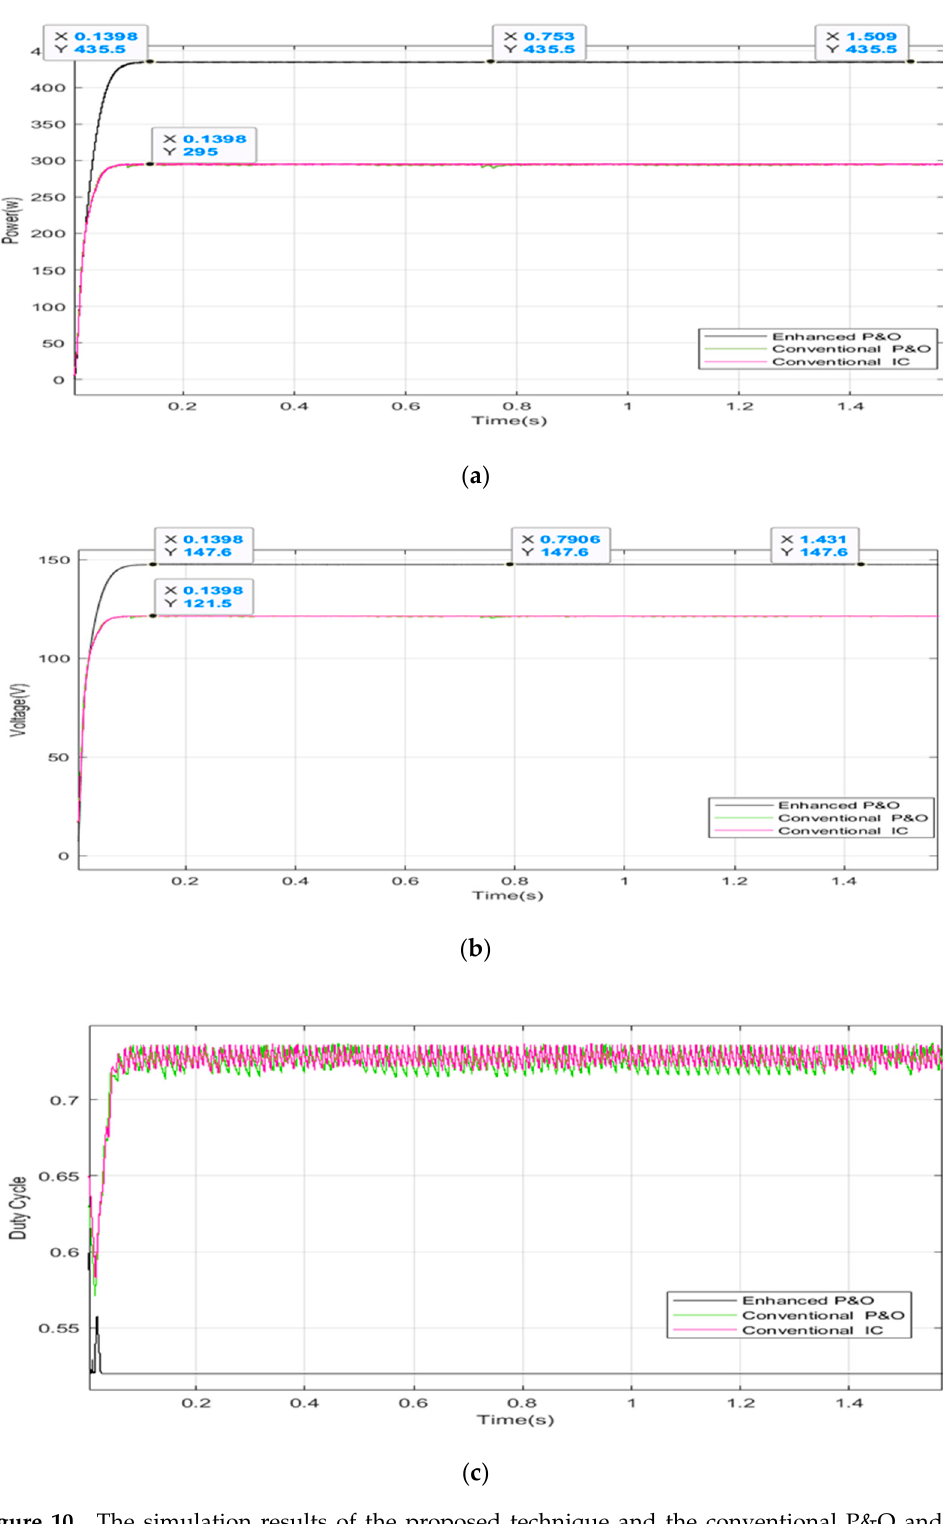
Figure 10. The simulation results of the proposed technique and the conventional P&O and IC techniques for Case Two: ( a ) Tracked output power; ( b ) Output voltage of the boost converter; ( c ) Duty cycle behaviors.